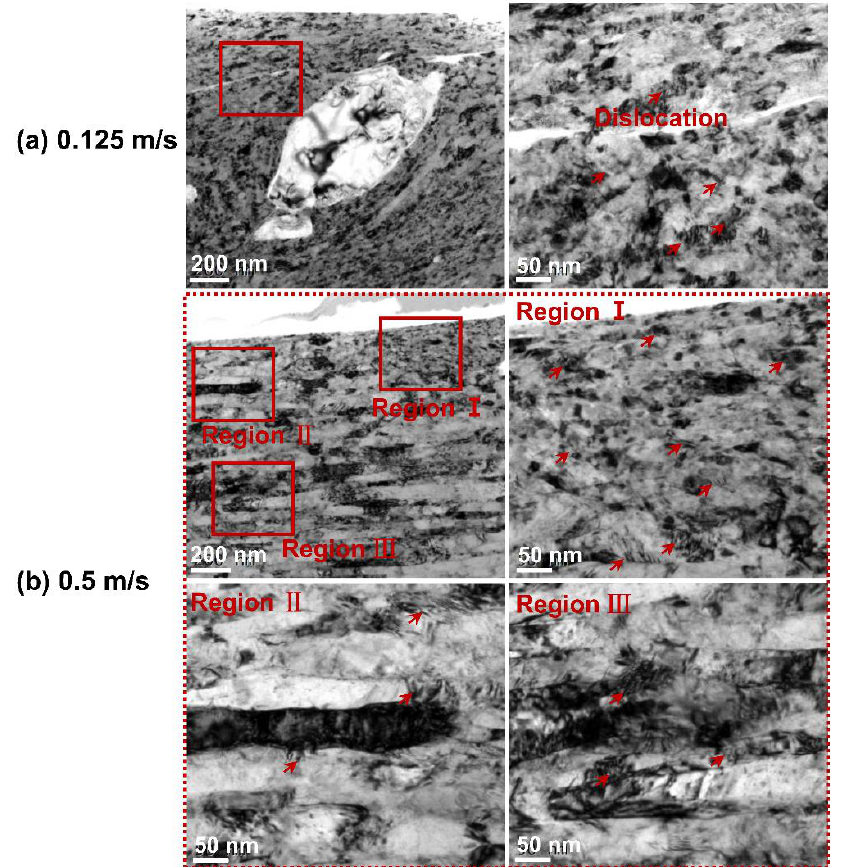
Figure 8. TEM morphologies of Monel 400 alloy after mechanical wear tests at ( a ) 0.125 m/s and ( b ) 0.5 m/s.